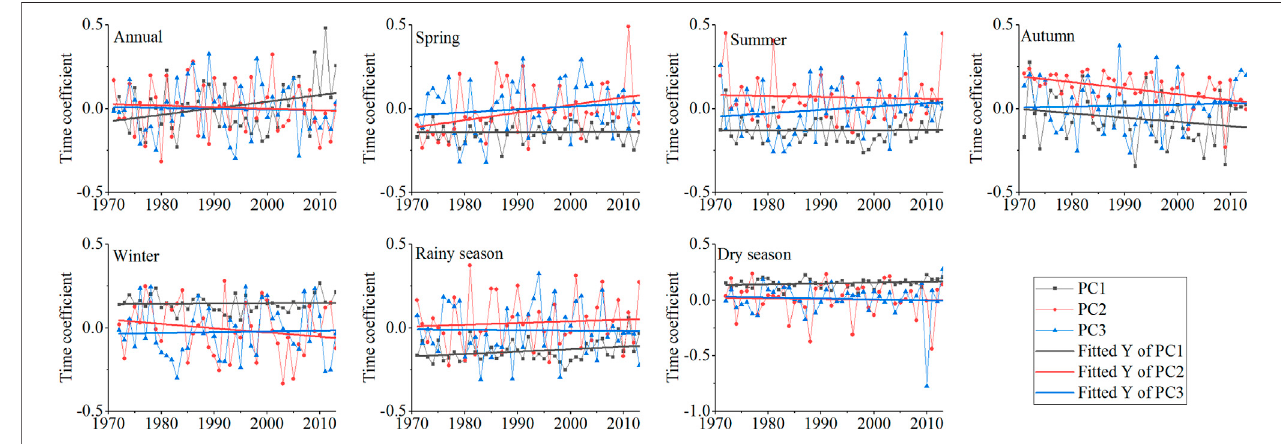
FIGURE 7 | Time coef fi cients of the fi rst three principal components.